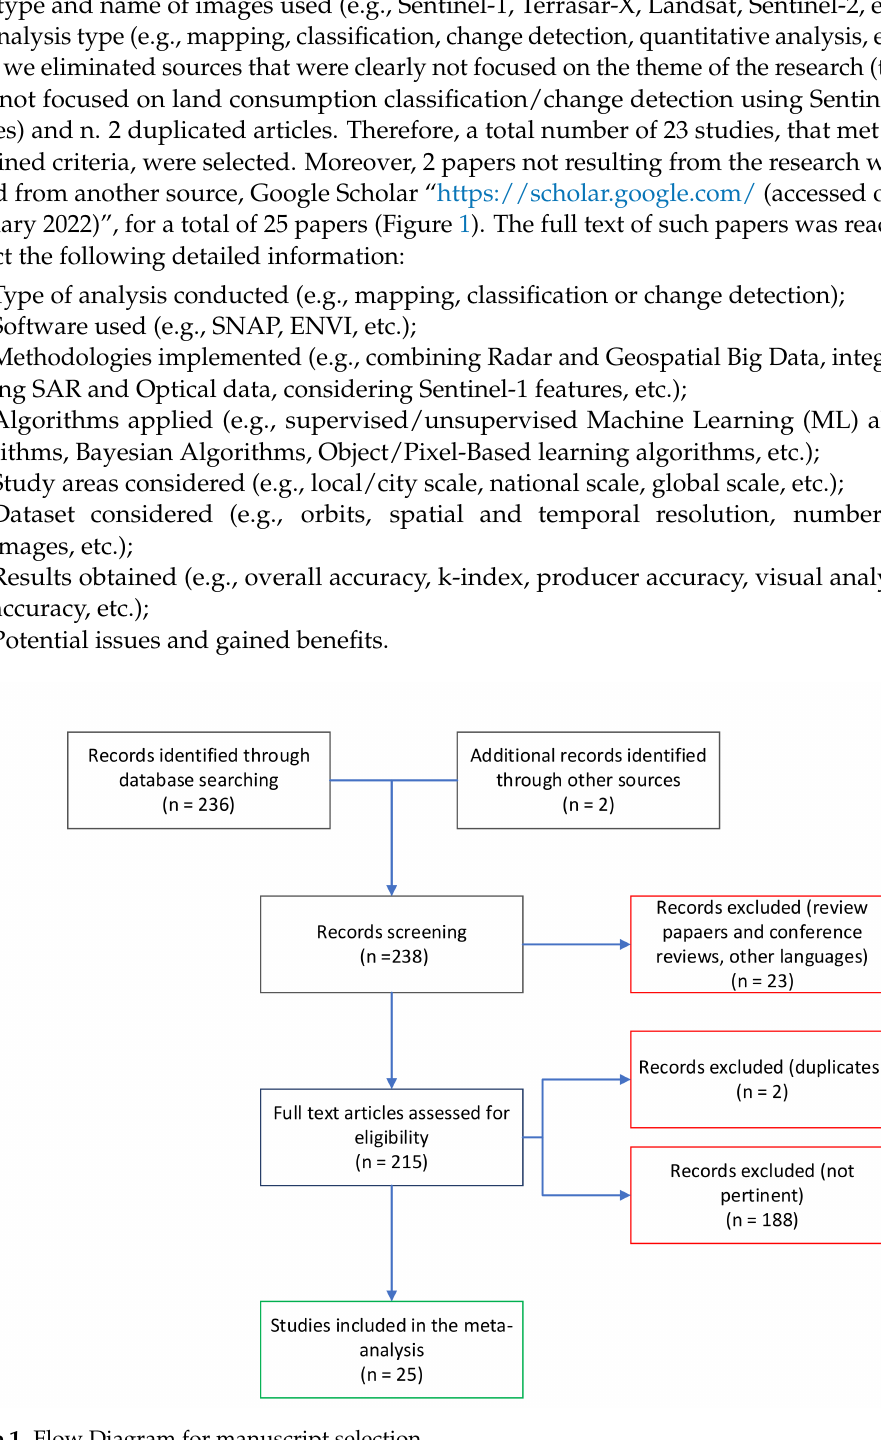
Figure 1. Flow Diagram for manuscript